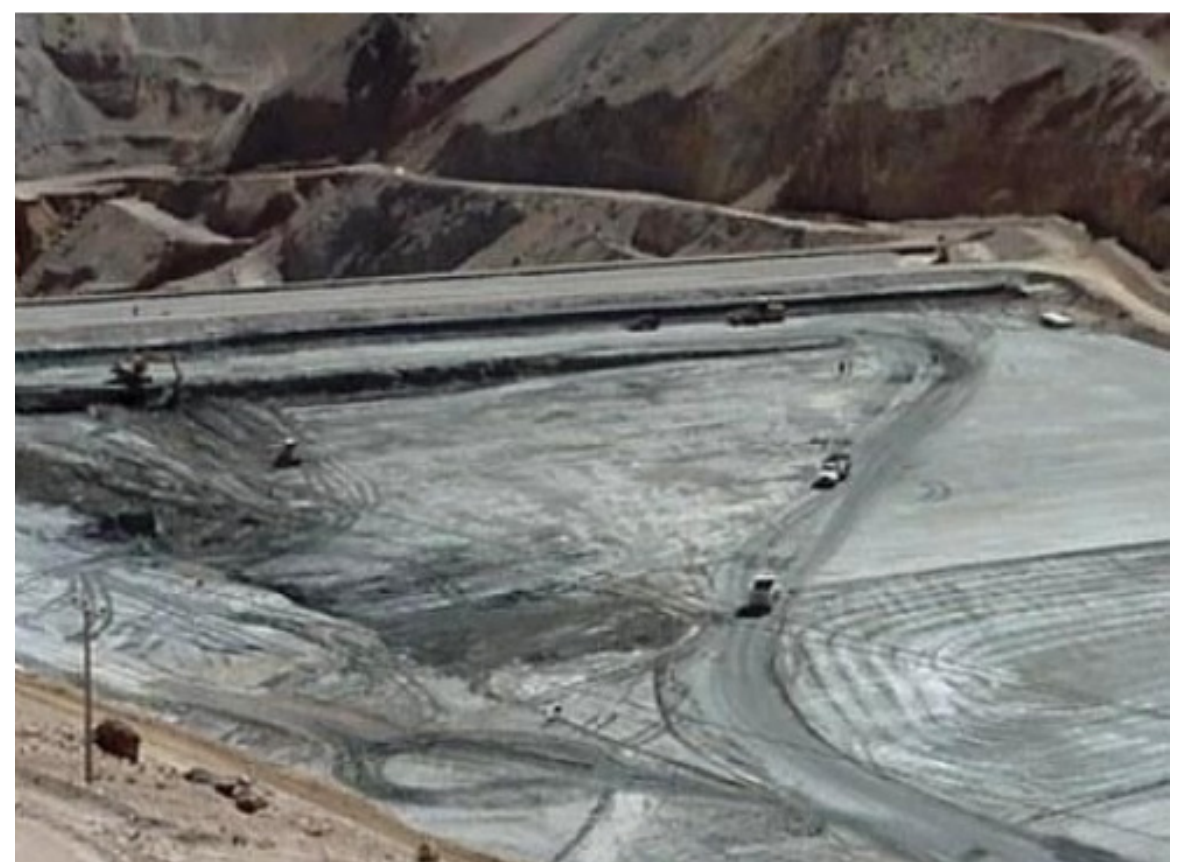
Figure 22. El Indio Filtered TSF Layout [53].